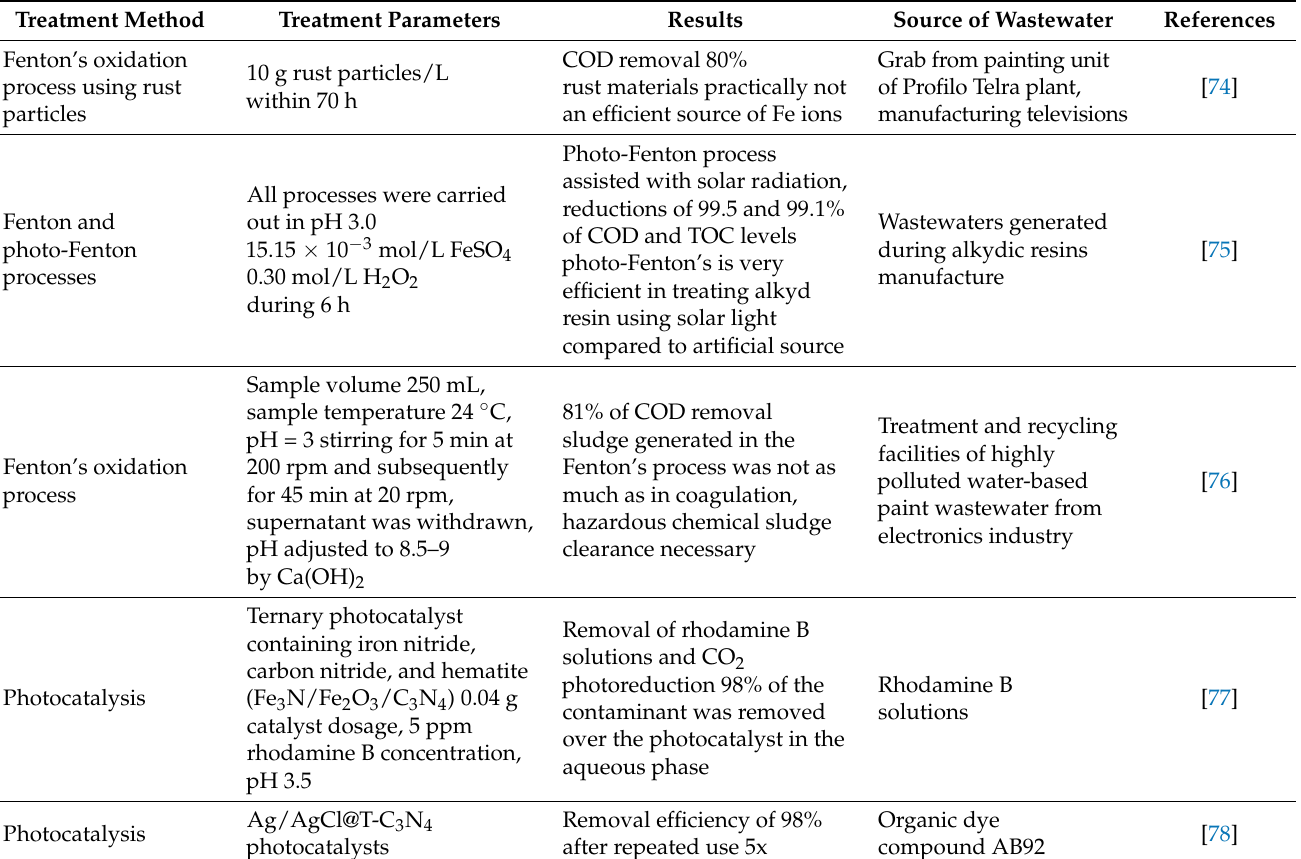
Table 4. AOPs treatment methods for paint industry